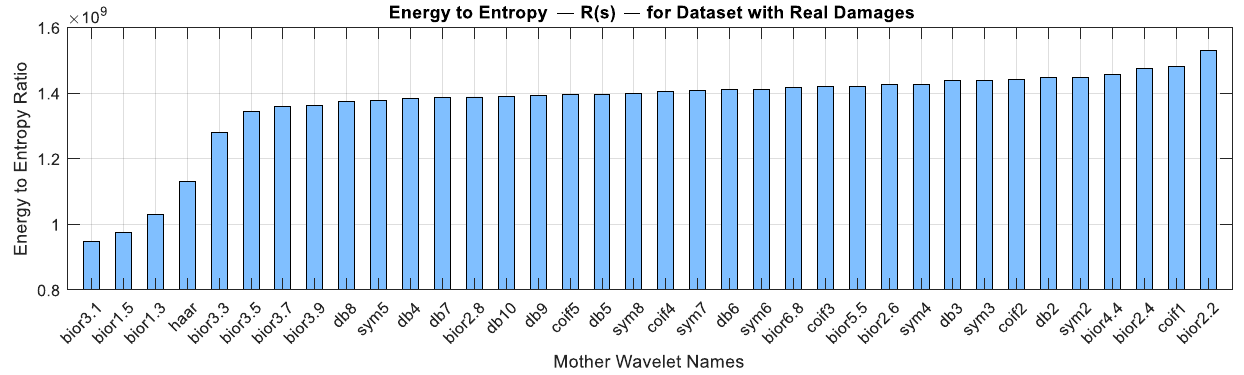
Figure 7. Energy to Entropy ratio for real damage data.